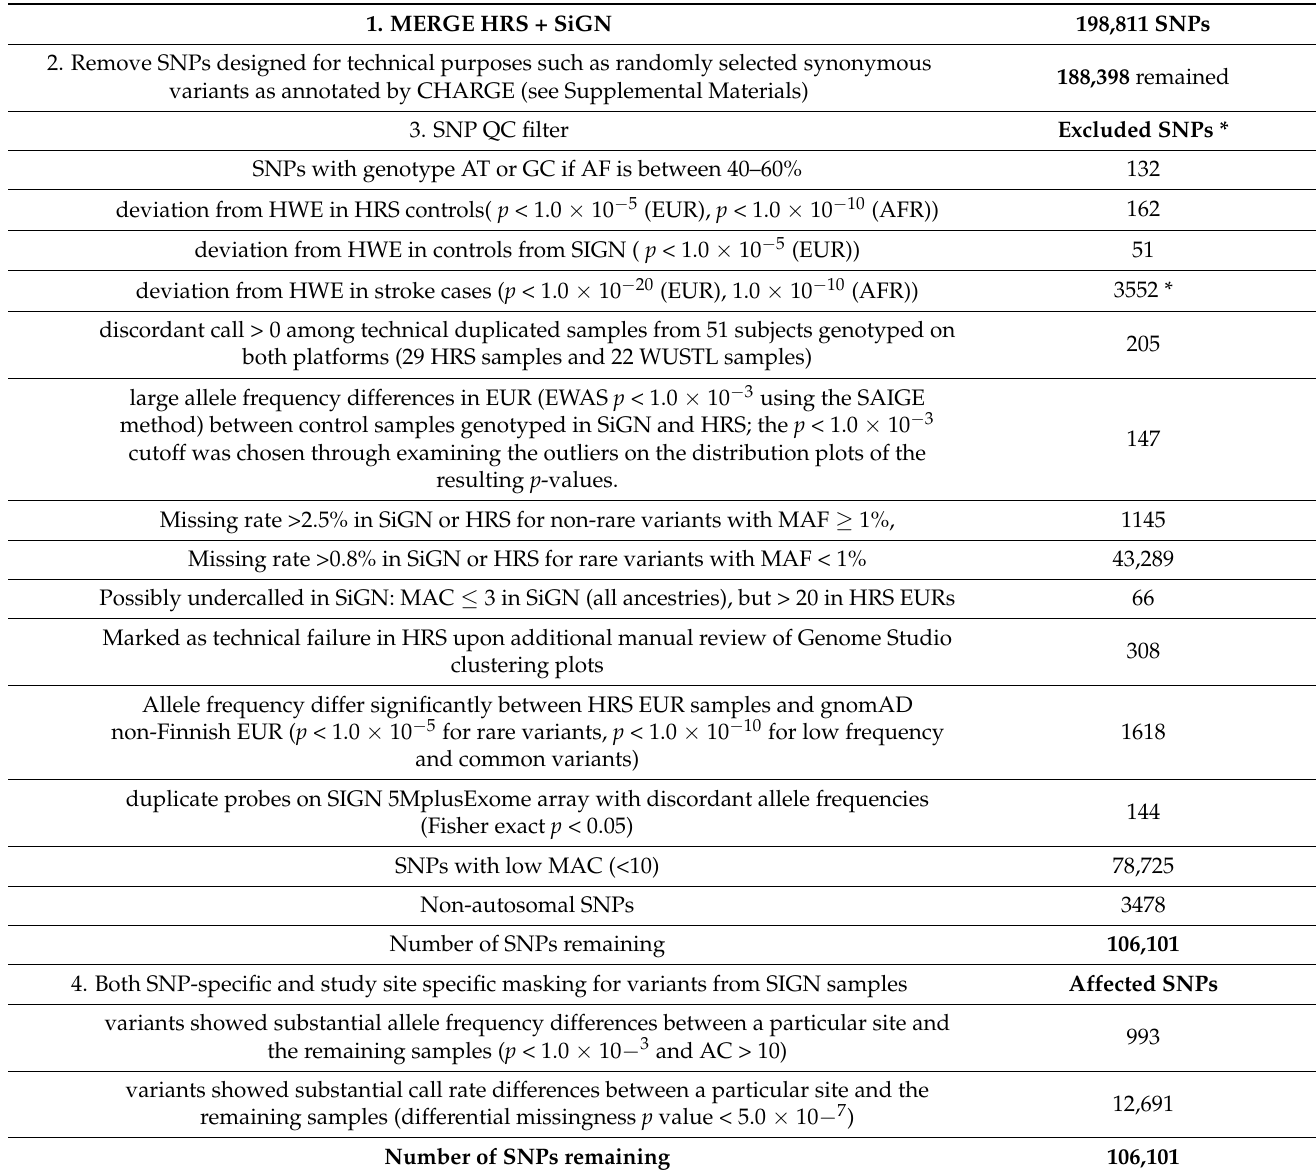
Table 2. SNP Quality control